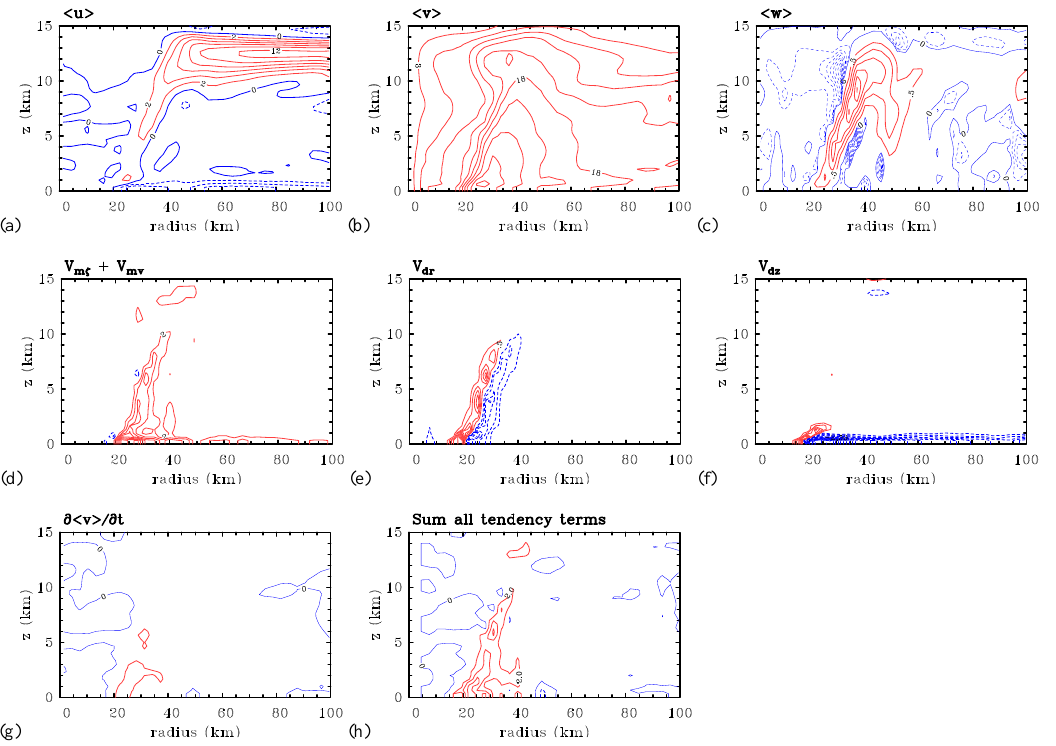
Fig. 12. Terms of the tangential wind tendency equation for the simulation AX3k, averaged during the rapid intensification stage (77 - 83 h). Red color denotes positive values; blue color denotes negative values. (a) Radial velocity h u i (Contour interval 2 m s − 1 ); (b) Tangential velocity h v i (Contour interval 3 m s − 1 ); (c) Vertical velocity h w i (Contour interval for positive 0.5 m s − 1 ; negative contours -0.05, -0.1, -0.15, -0.2 m s − 1 ); (d) Sum of mean vorticity influx and vertical advection V mζ + V mv (Contour interval: 2 m s − 1 h − 1 ); (e) Radial (subgrid-scale) diffusive tendency V dr (Contour interval 0.5 m s − 1 h − 1 ); (f) Vertical (subgrid-scale) diffusive tendency V dz (Contour interval 0.5 m s − 1 h − 1 ); (g) Mean tangential wind tendency ∂ h v i /∂t (Contour interval 2 m s − 1 h − 1 units); (h) Sum of all tendency terms (Contour interval 2 m s − 1 h − 1 ).